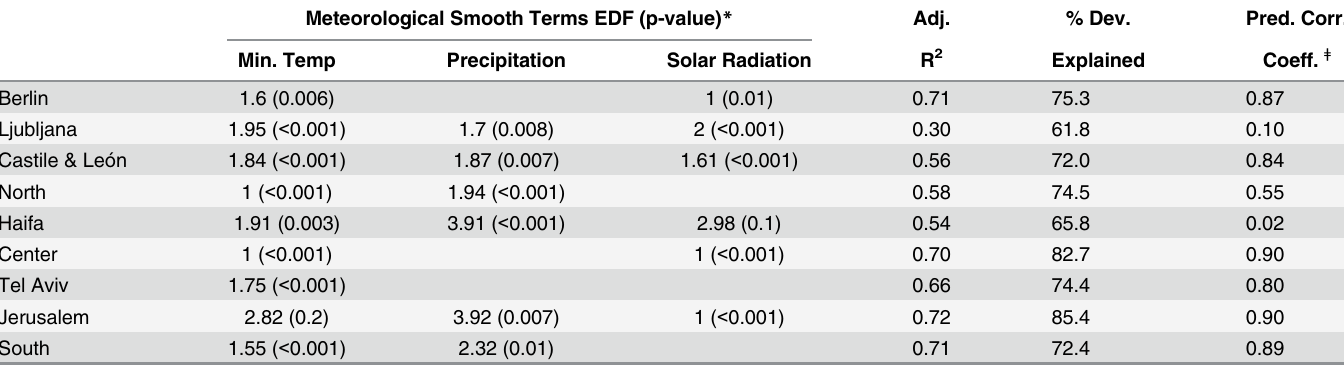
Table 4. Model 2 (with minimum temperature) regression parameters. Models were adjusted for previous weeks ’ influenza